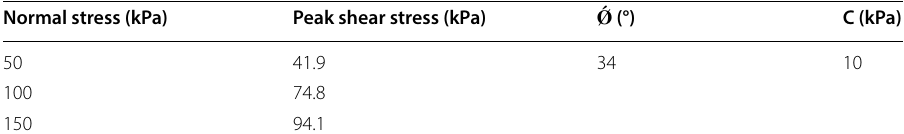
Table 1 Results of direct shear test Normal stress (kPa)